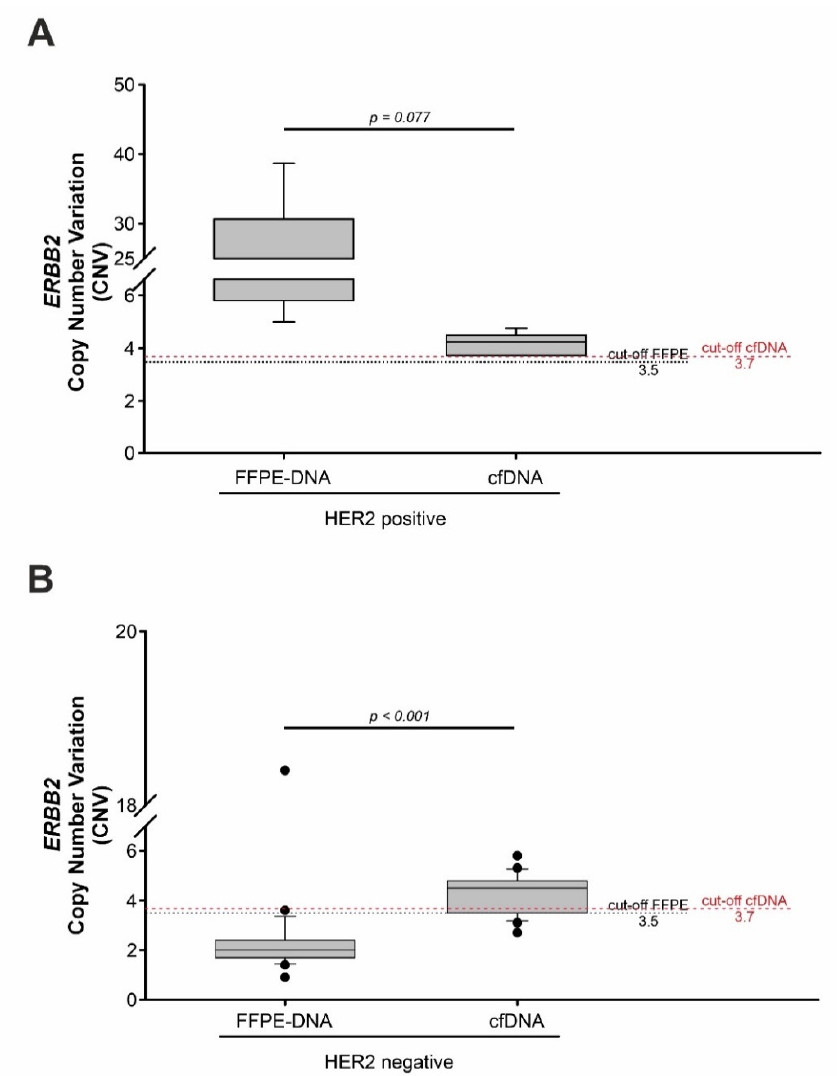
Figure 4. The box plot shows ERBB2 CNV value distribution in FFPE-DNA and time-matched cfDNA samples in the HER2 positive subgroup ( A ) and in the HER2 negative subgroup ( B ) in the prospective cohort. ( A ) No difference was observed when comparing the FFPE-DNA and cfDNA of HER2 positive patients. The p -value was calculated using a two-tailed Student’s t -test. ( B ) A statistically significant difference was present between the FFPE-DNA and the cfDNA of the HER2 negative group. The p- value was calculated using a two-tailed Wilcoxon Mann-Whitney test. A p -value < 0.05 was considered statistically significant. FFPE, formalin-fixed paraffin-embedded; cfDNA, cell-free DNA.